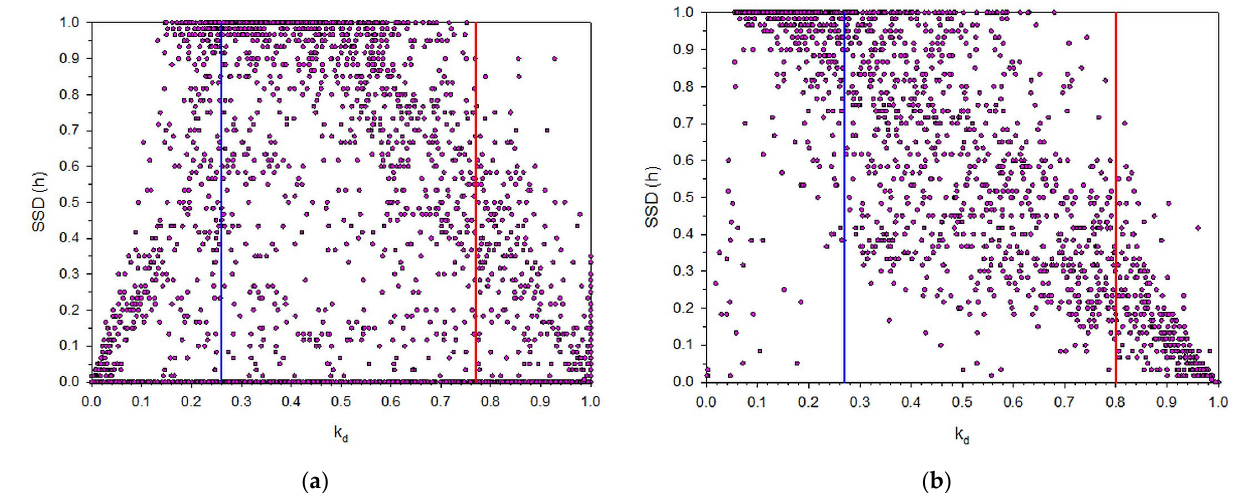
Figure 13. Determination of clear, intermediate, and overcast skies for the ( a ) GAN and ( b ) OHY sites.